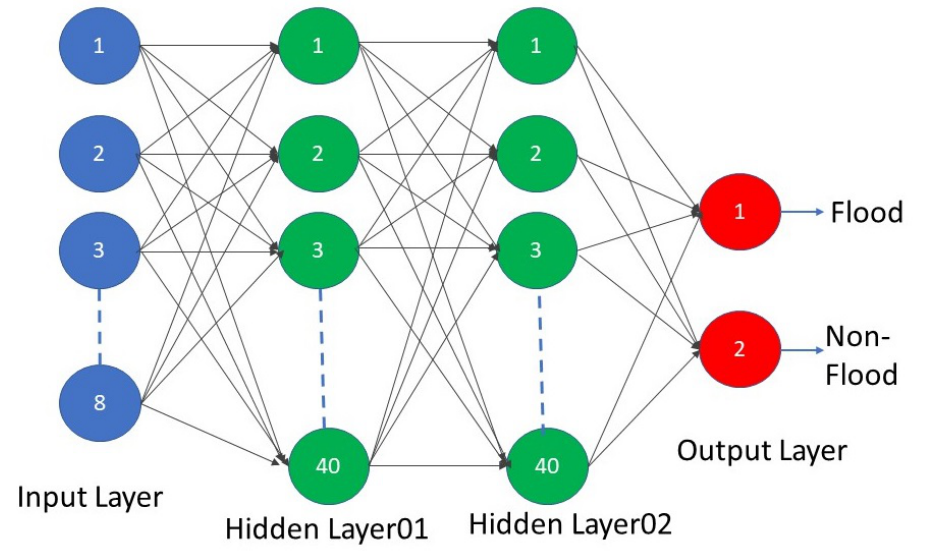
Figure 4. Multi-layer Perceptron